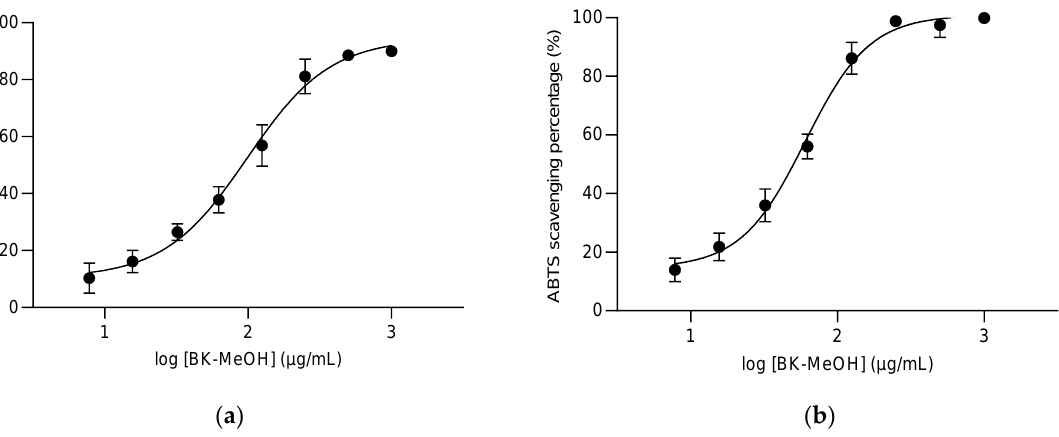
Figure 1. ( a ) The dose-response curve of the inhibitory activity of BK-MeOH against DPPH, ( b ) The dose-response curve of the inhibitory activity of BK-MeOH against ABTS ●+ . Each point represents the average of triplicate measurements. Table 2. Antioxidant activities expressed in IC 50 between methanolic flowers, leaves, and barks extract of A. saligna and vitamin C in DPPH and ABTS ●+ scavenging assay, **** p < 0.0001 of the indicated extracts against vitamin C ( n = 3, ANOVA, Tukey).